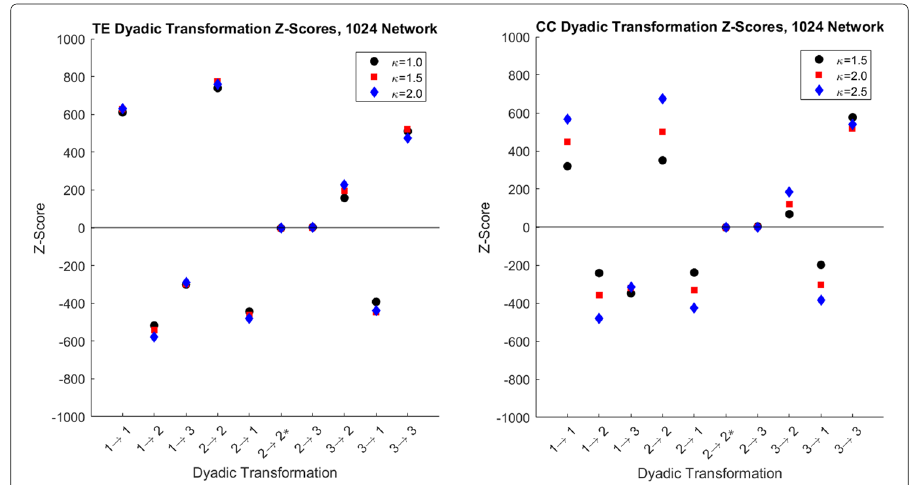
Fig. 10 Dyadic Z -scores for 1024 neuron network. Shown are the Z -scores for both the TE and GC reconstructions. While the pattern from the smaller network is the same, we note that for both cases, the magnitude of Z -scores are significantly higher. We also use different values of κ for this network than the 100 neurons network